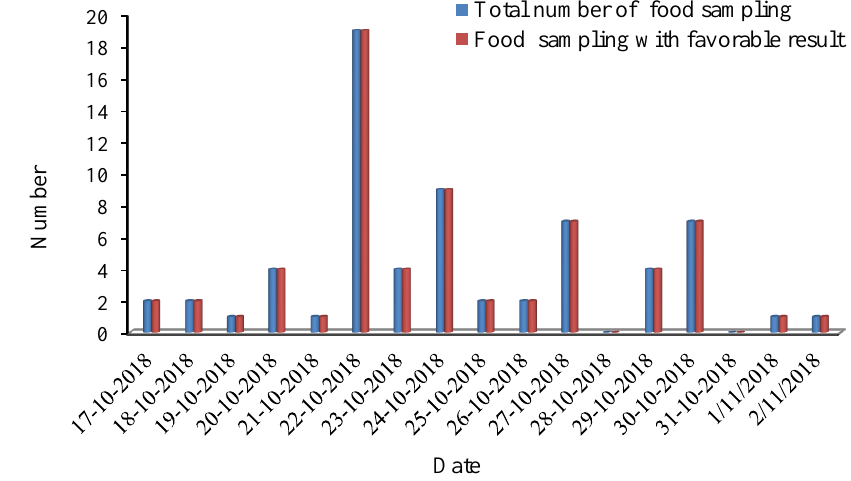
number of food sampling Food sampling with favorable